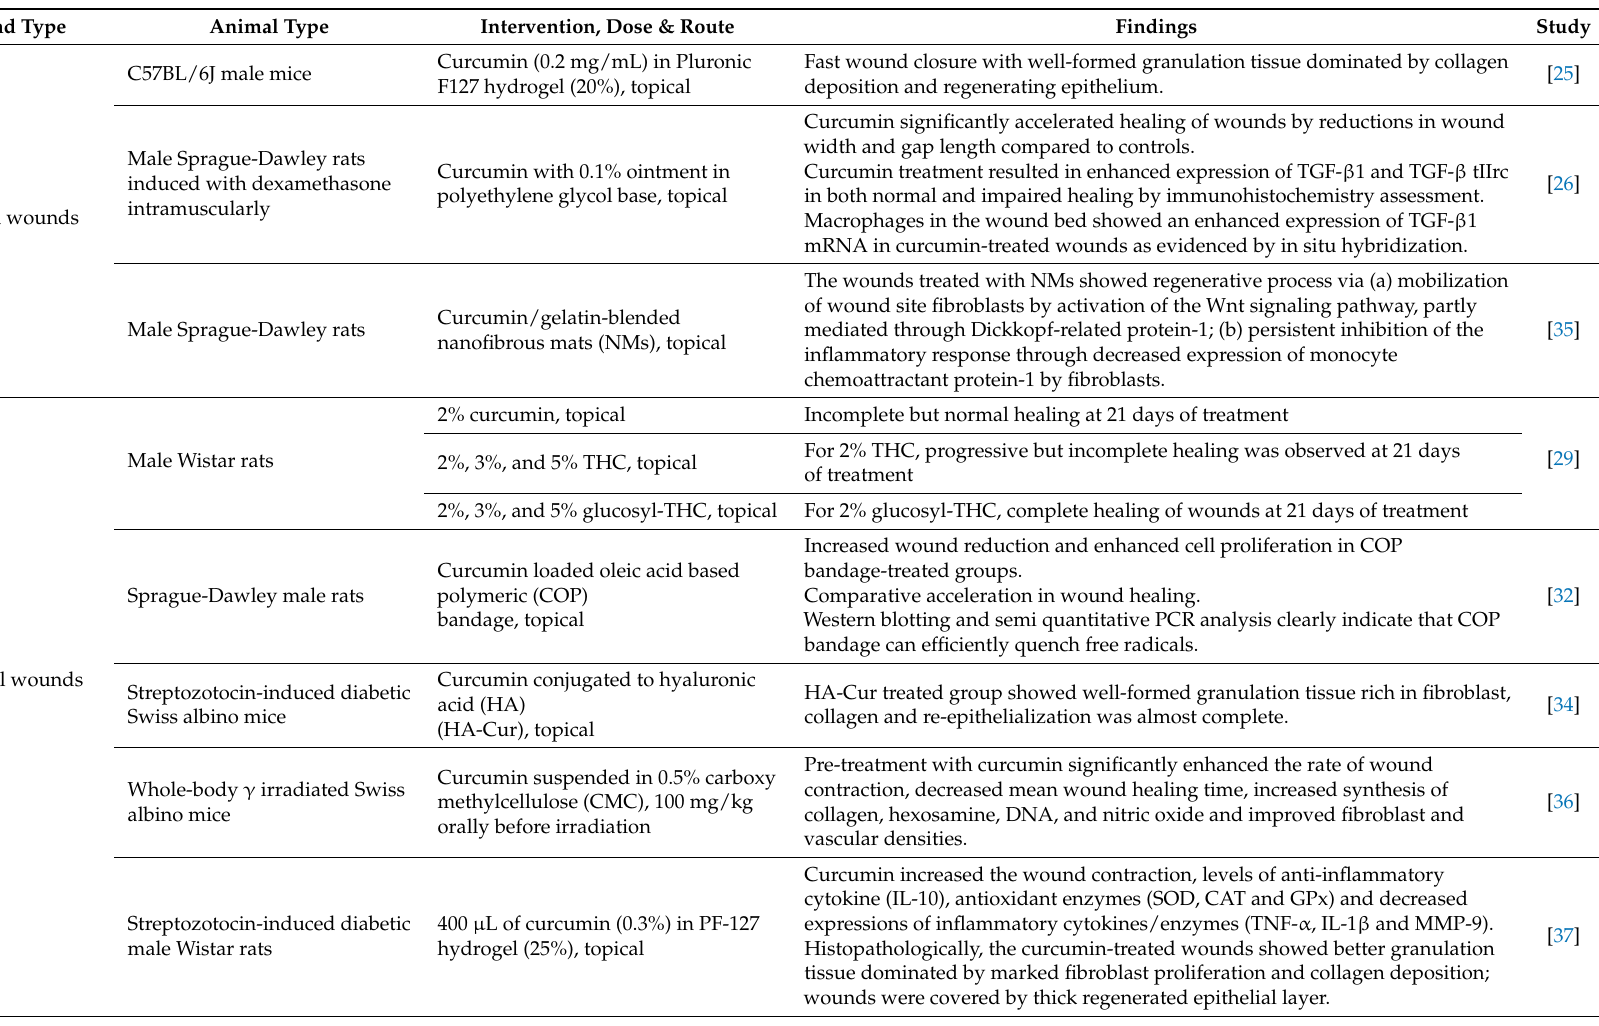
Table 1. The effects of curcumin on wound healing in animal